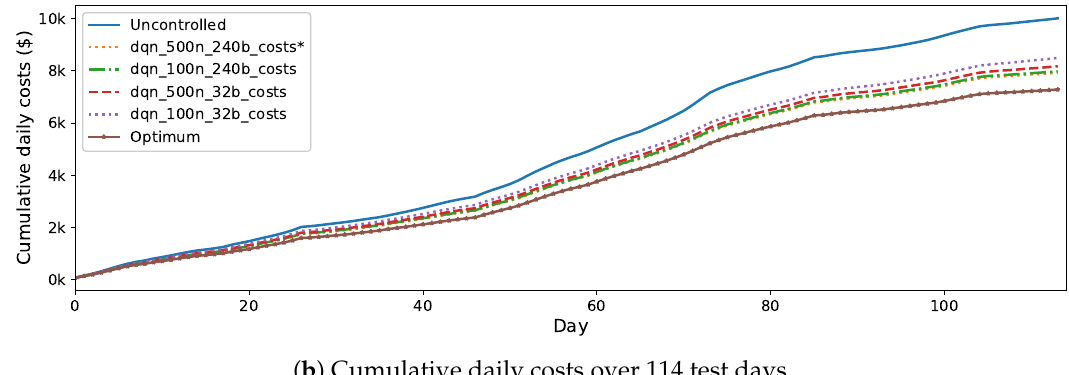
Figure 11. Daily operating costs and the corresponding cumulative daily costs over 114 test days obtained by the proposed approach using different